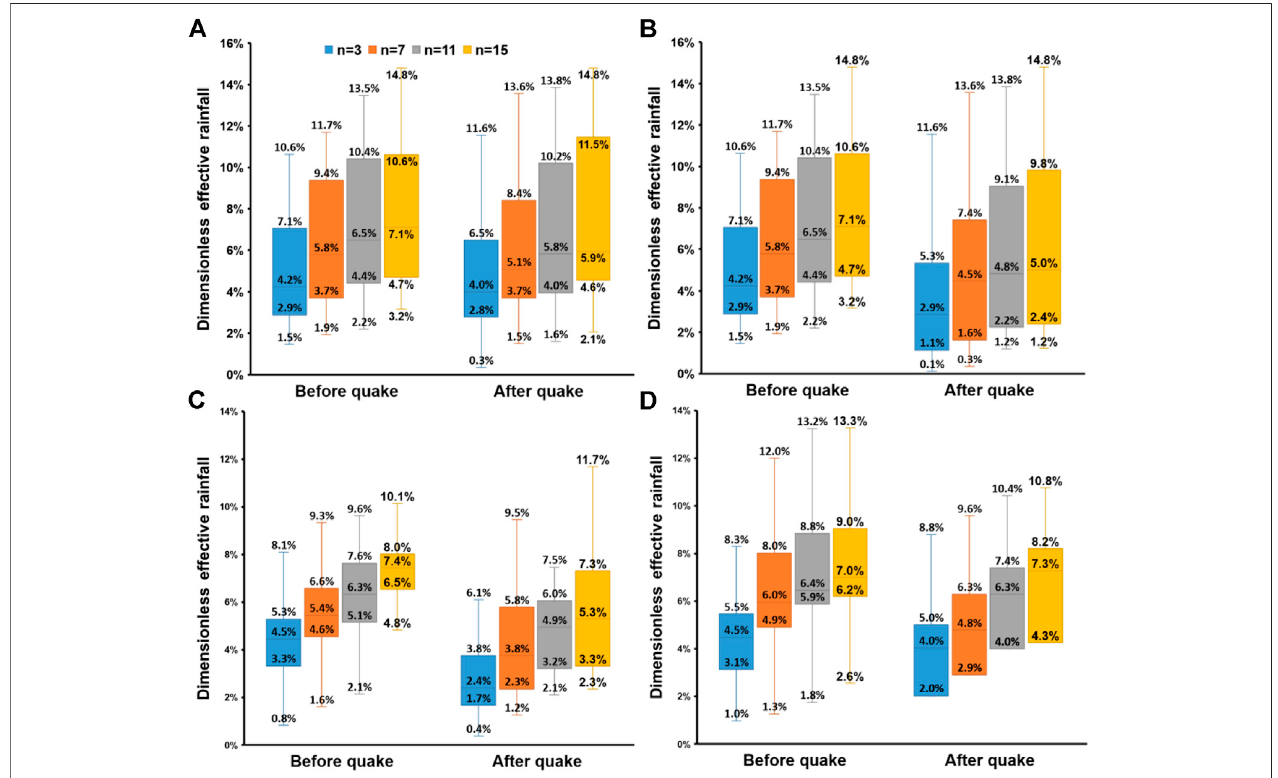
FIGURE2| BoxplotsofDERforWenchuan (A,B) ,Lushan (C) ,andJiuzhaigou (D) earthquakes.Subplot (A) excludesthedebris fl owsoccurringonMay12,2008, while subplot (B) includes those events. n denotes effective antecedent rainy days. The fi rst quartile marks the bottom of the box, and the third quartile marks the other end of the box. The backline in the box denotes the